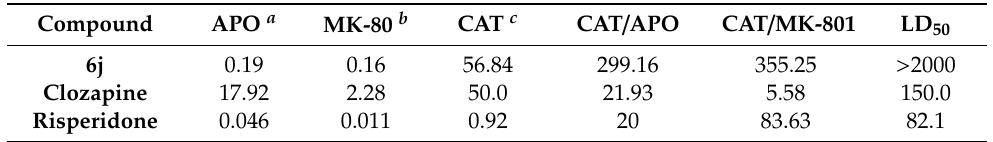
Table 4. In Vivo Pharmacological Profile of Compound.